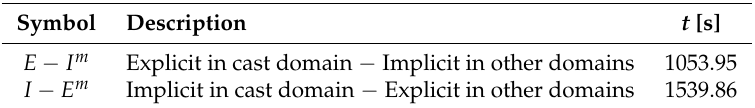
Table 6. A total time t of computations obtained for the mixed time partitioning methods ( m = 15). The different intergration methods and the different time